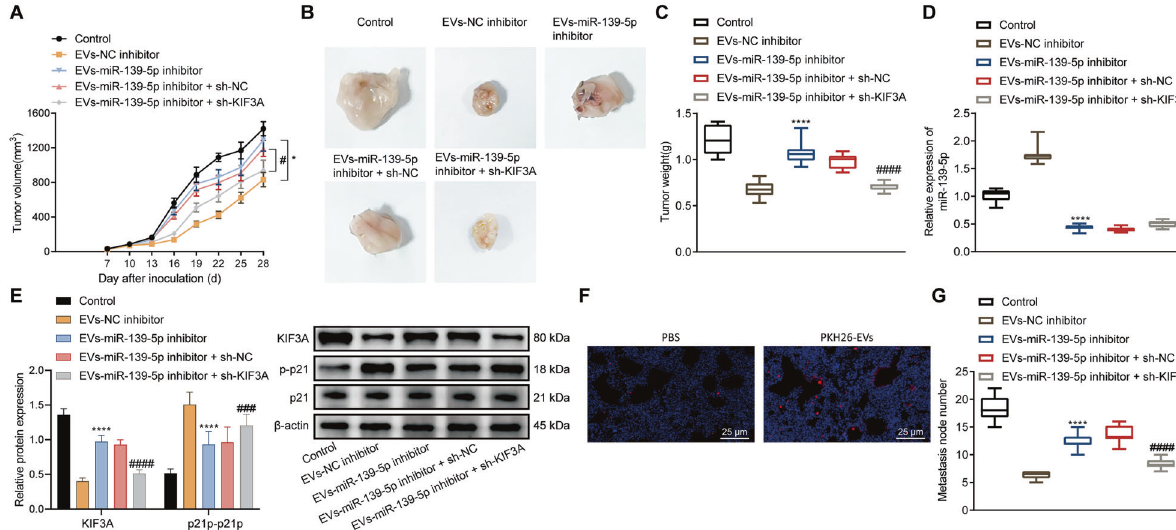
Fig. 7 miR-139-5p delivered by BMSCs-EVs impedes the tumorigenesis and metastasis of bladder cancer cells in vivo by regulating the KIF3A/p21 axis. A Tumor volume of mice treated with EVs-miR-139-5p inhibitor or combined with sh-KIF3A. B Representative images showing xenografts in mice treated with EVs-miR-139-5p inhibitor or combined with sh-KIF3A. C Tumor weight of mice treated with EVs- miR-139-5p inhibitor or combined with sh-KIF3A. D miR-139-5p expression in tumor tissues of mice treated with EVs-miR-139-5p inhibitor or combined with sh-KIF3A detected using RT-qPCR. E The expression of KIF3A and ratio of p-p21/p21 in tumor tissues of mice treated with EVs-miR-139-5p inhibitor or combined with sh-KIF3A tested by western blot analysis. F The location of EVs labeled with PKH26 (red fl uorescence) in the lung tissue of nude mice observed under a fl uorescence microscope. Scale bar: 25 μ m. G Lung metastatic nodules in mice treated with EVs-miR-139-5p inhibitor or combined with sh-KIF3A observed by HE staining. Measurement data were expressed as mean ± standard deviation, One-way ANOVA was conducted for multi-group data comparison, followed by Tukey ’ s post hoc test. Repeated measures ANOVA was used for comparison of data between multiple groups at different time points, followed by Bonferroni post hoc test. * p < 0.05 or **** p < 0.0001 vs. EVs-NC-inhibitor group. # <0.05 or ### p < 0.001, #### p < 0.0001, vs. EVs-miR-139-5p- inhibitor + sh-NC group. n = 10 for mice in each